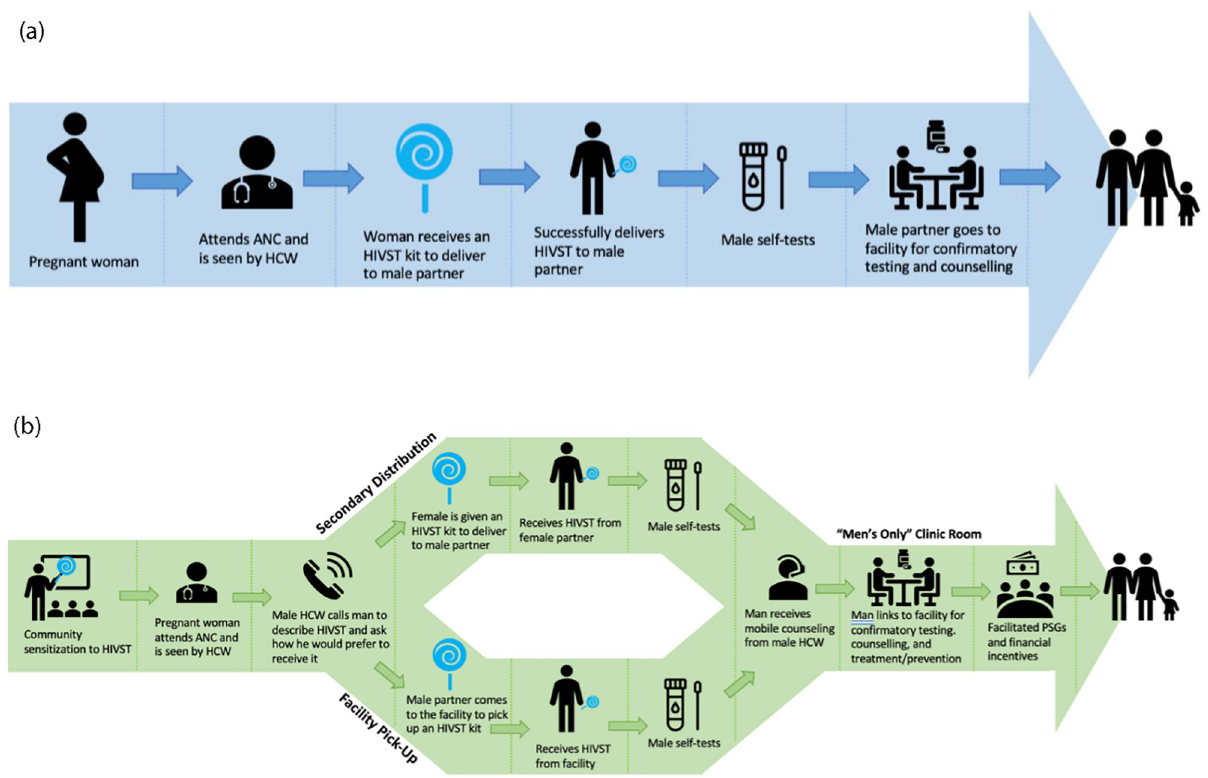
Fig 1. a. Standard cascade of HIVST secondary distribution. b. Re-envisioned cascade of HIVST distribution � . � PSG: peer support groups.